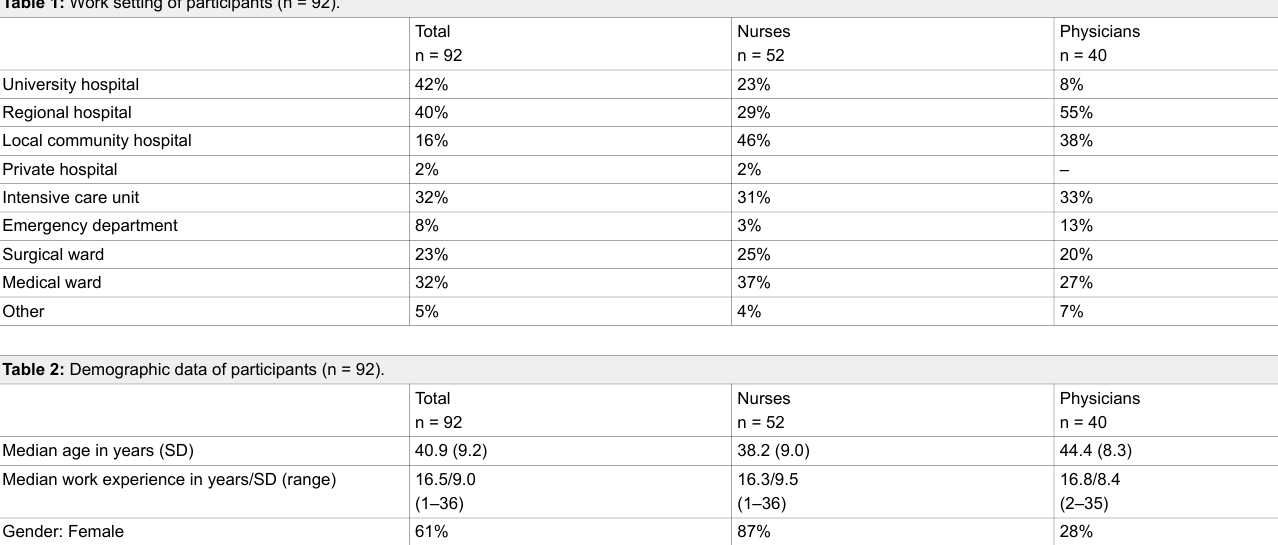
Table 1: Work setting of participants (n = 92).